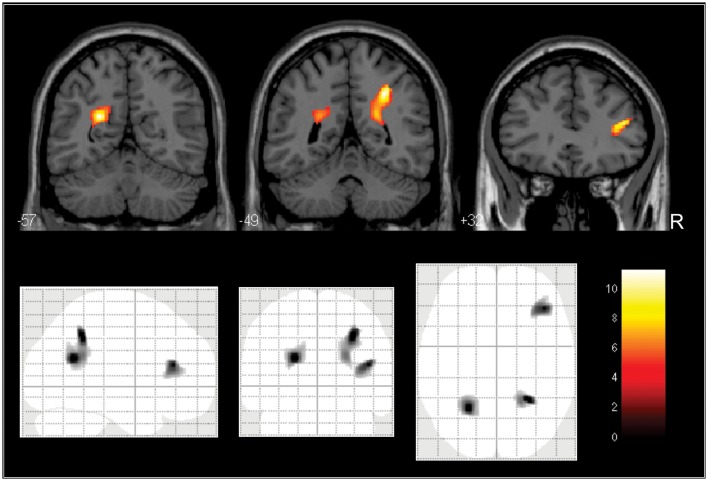
Voxelwise WM volume comparisons between the 3 subgroups divided according to their degree of cardiovascular risk, with gender, age and years of education as cofounding variables. At the bottom, glass-brain projections show three foci of between-group WM volume difference (in the right juxtacortical dorsolateral prefrontal WM and bilaterally in deep parietal regions). For display purposes, the statistical parametric map was filtered at p < 0.01 (uncorrected for multiple comparisons) with a minimum cluster extent of 250 voxels. At the top, the frames highlight (in yellow) the three foci of between-group WM volume difference overlaid on coronal brain slices spatially normalized into an approximation to the Talairach and Tournoux stereotactic atlas, located bilaterally in deep parietal regions (first and second frames) and in the right juxtacortical dorsolateral prefrontal WM (third frame). All findings retained statistical significance when we used the small-volume correction approach (p = 0.05, family-wise error corrected for multiple comparisons). Post-hoc two-group comparisons showed significantly reduced WM volume in the high-risk subgroup in comparison to the low-risk and intermediate-risk subgroups in the three regions (see statistical details for these comparisons in Table 2).